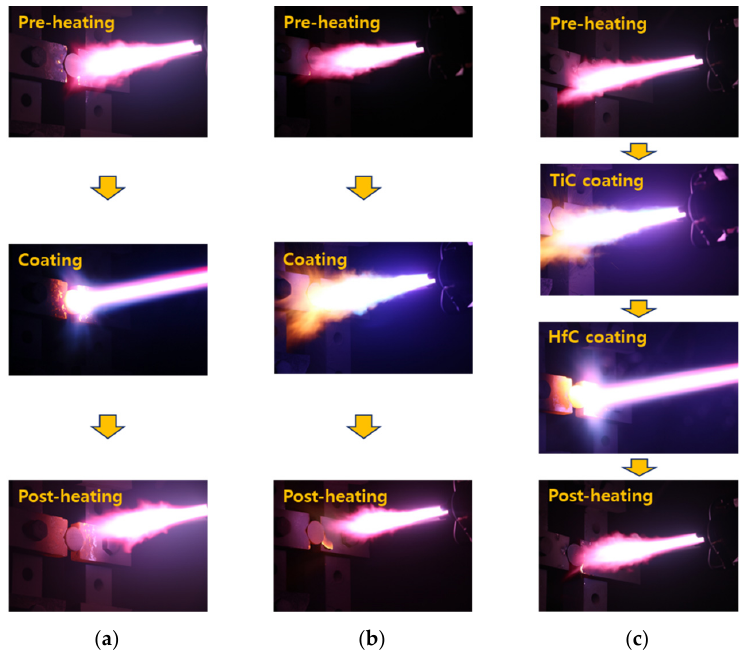
Figure 3. Plasma spray coating process. ( a ) HfC coating; ( b ) TiC coating; ( c ) HfC/TiC coating.